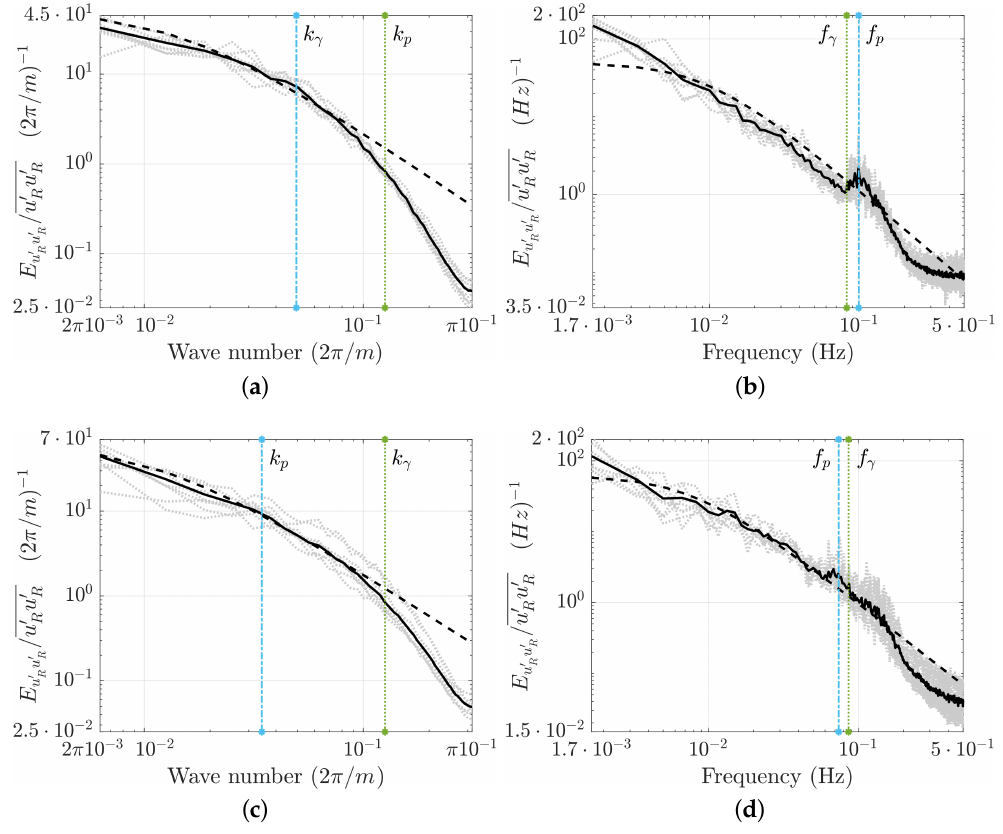
Figure 5. ( a , c ) Wave-number k and ( b , d ) frequency f dependent 1D turbulent spectra E u (cid:48) Case 01, and ( c , d ) Case 02a. Observed 10-min spectra in light grey, and the 3-h average in black full lines. The Engineering Sciences Data Unit (ESDU) reference is given in black dashed lines. Vertical blue lines stand for the wave peak scales k p and f p , and green lines show the filter scales k γ and f γ , for wave-number and frequency spectra,